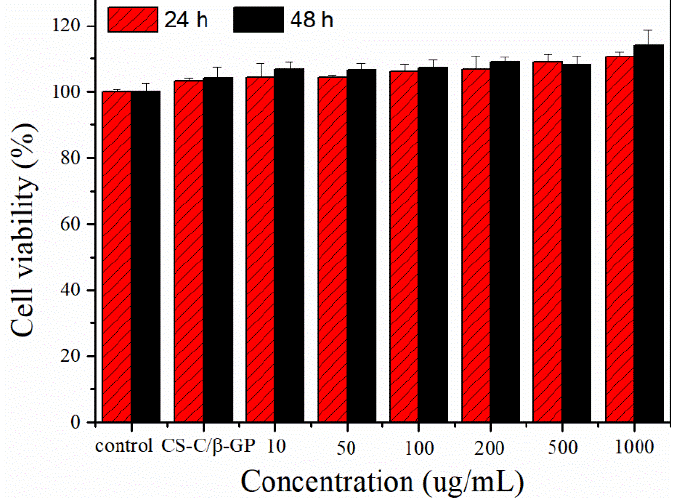
Figure 7. E ff ects of CS-C / OP / β -GP on the L929 cell Figure 7. Effects of CS-C/OP/ β -GP on the L929 cell viability.